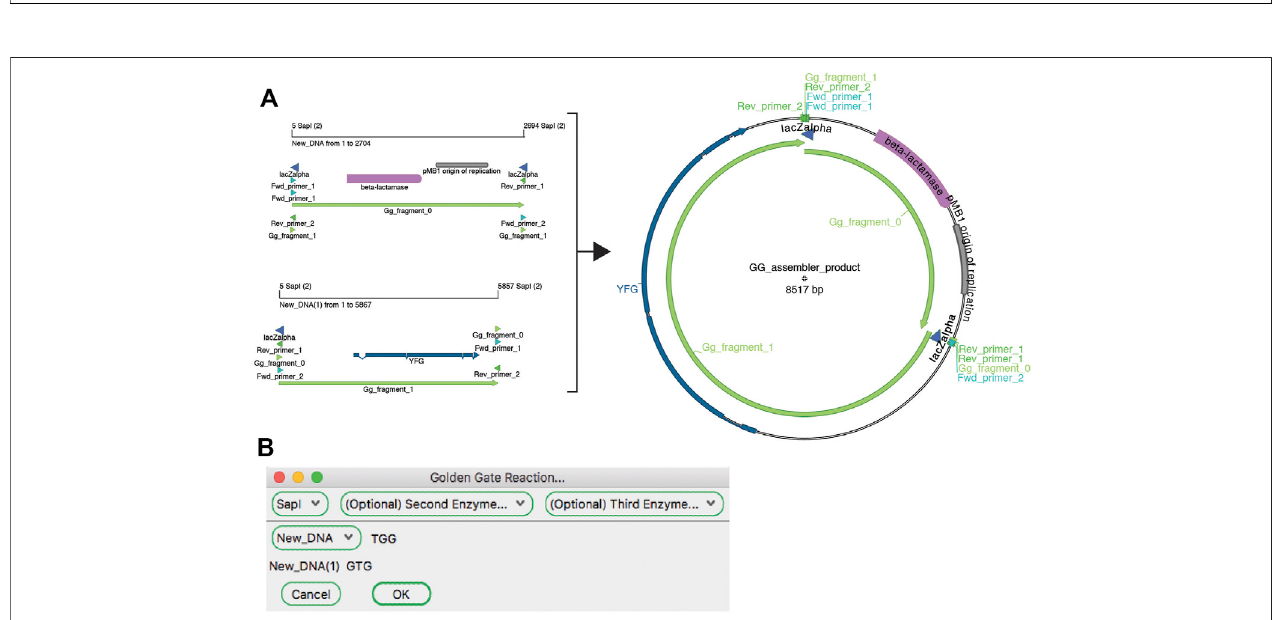
FIGURE5 | The Golden Gate Designer tool. (A) Graphicmaps of theinputsequences (left) and output sequence (right). (B) The Golden Gate Designer is fi rst used to specify two PCR products: YFG and pUC19. The tool then designs four PCR primers and the sequence of the Golden Gate reaction, the product sequence shown in (A)